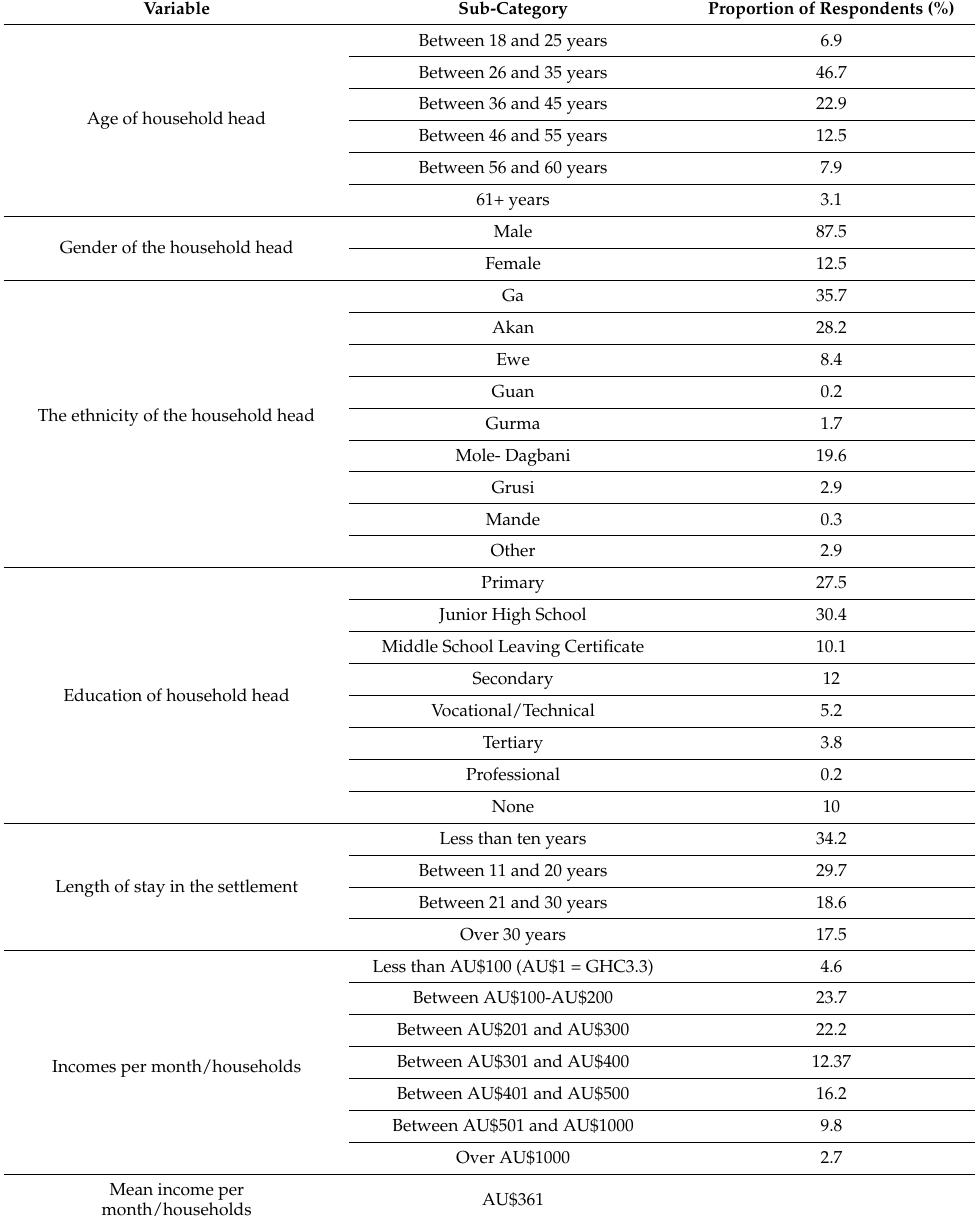
Table 2. Socio-demographic characteristics of the Study